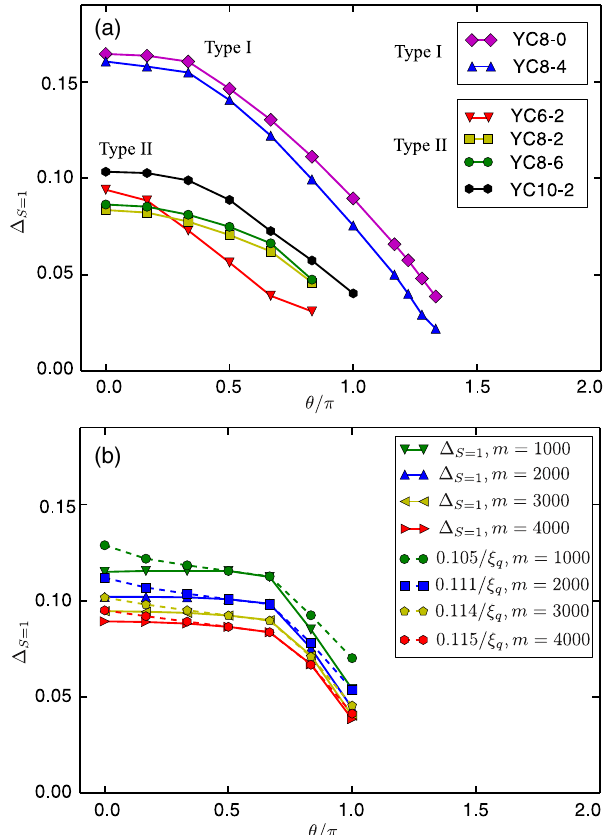
FIG. 3. (a) Upper bound on the spin gap Δ S ¼ 1 under the twist boundary condition θ for J 2 ¼ 0 ; the estimate is obtained using DMRG bond dimension m ¼ 4000 and using the lowest-energy topological sector. Data end at the failure of adiabaticity. The qualitative behavior depends on the type of cylinder (I or II), which in a DSL would be gapless at θ ¼ 2 π , π , respectively. (b) Dependence of the spin gap Δ S ¼ 1 (solid line) and S z ¼ 1 correlation length ξ (dashed line) on the spin flux θ and DMRG bond dimension m . Data are taken with J 2 ¼ 0 . 05 on the type II YC8-2 cylinder. Generally, the estimated gap decreases with the bond dimension m ; the larger the system size is, the more likely we are to overestimate the spin